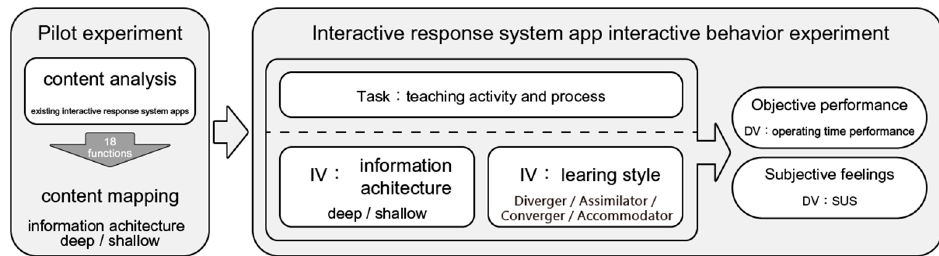
Figure 5. Experimental framework of this study.